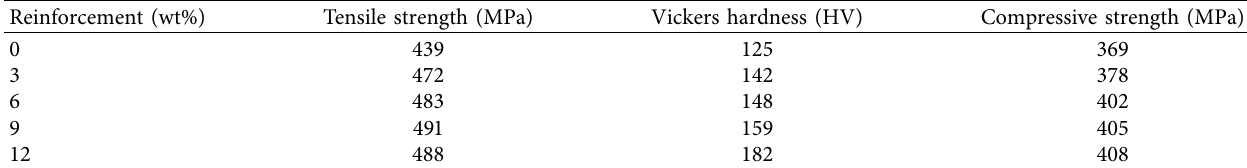
Table 4: Results of mechanical